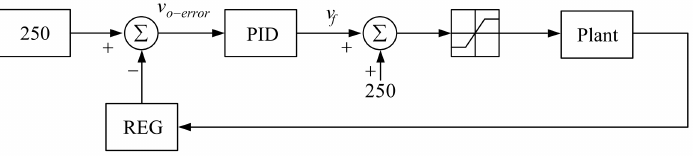
Figure 12. Control loop block diagram: PID: proportional-integral-derivative; REG: